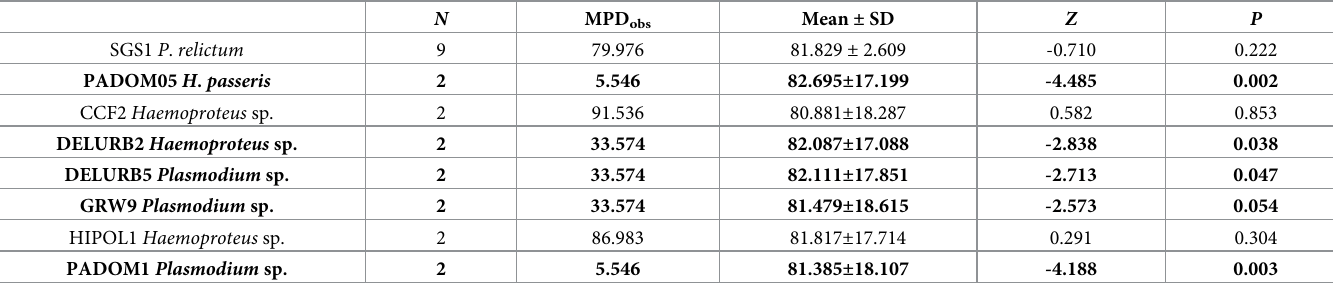
Table 4. Phylogenetic dispersion of parasite lineages infecting more than one host